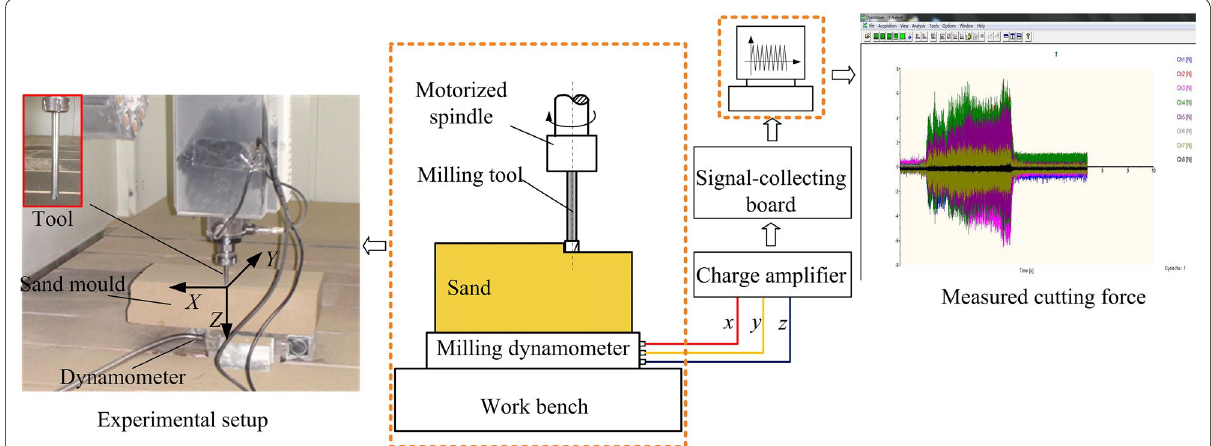
Figure 7 Measurement system of cutting